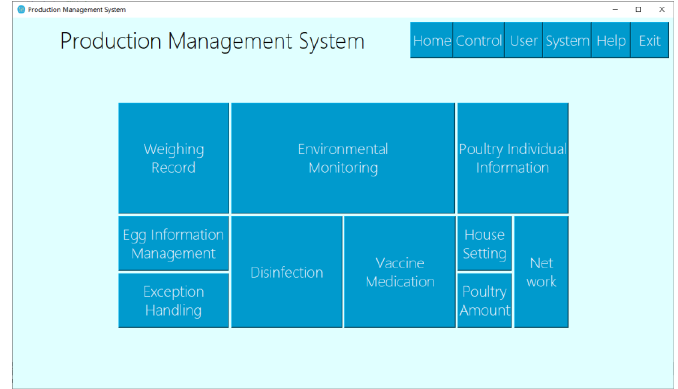
Figure 8. Management system home, includes ten function modules: weighing record, environ-